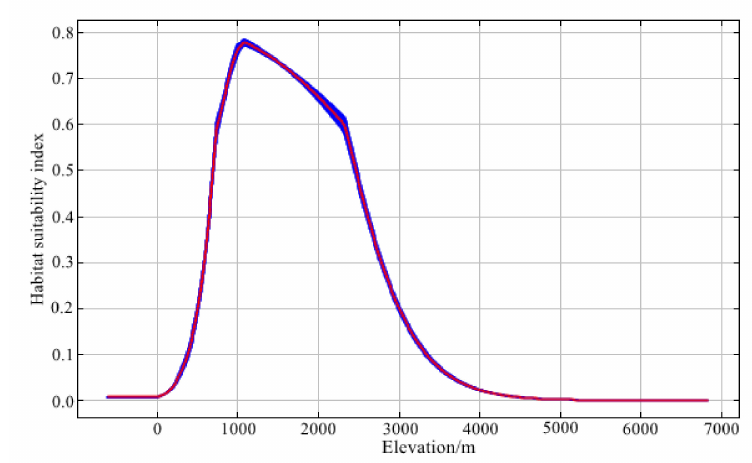
Figure 2. Response curve of C. pictus to elevation.